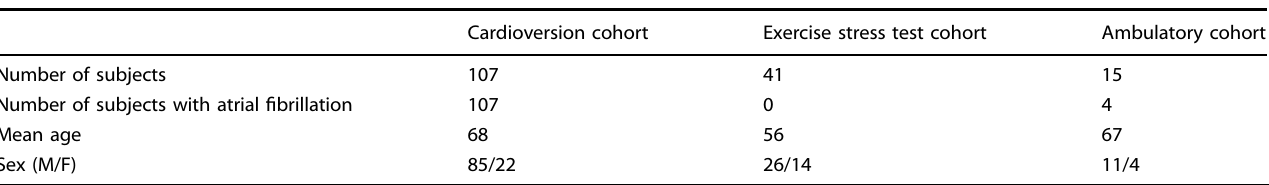
Table 1. Demographics of study participants collected for DeepBeat